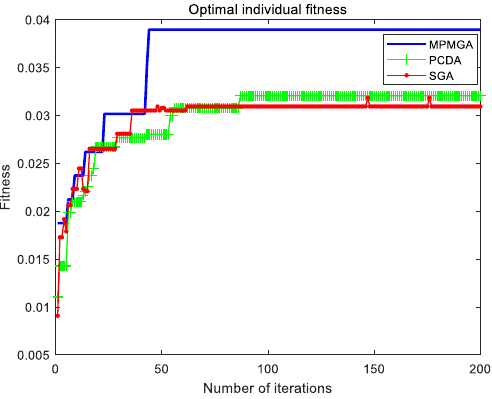
Figure 15. Evolutionary comparison diagram of optimal individual fitness.